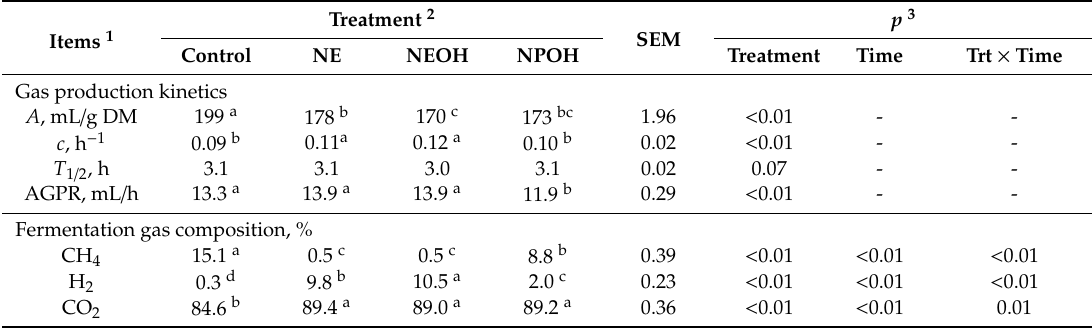
Table 1. E ff ect of NE, NEOH, and NPOH addition (10 mmol / L) to culture fluids on gas production kinetics and fermentation gas composition during 72 h